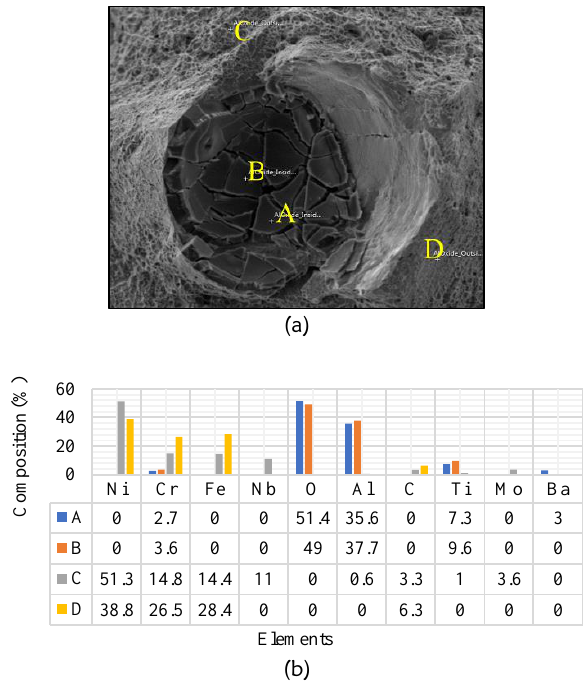
Figure 22: (a) Fracture of a brittle spherical particle in the ductile matrix of sample 17B (213.2 J/mm), and (b) EDS analysis at different locations showing high aluminium, titanium, and oxygen